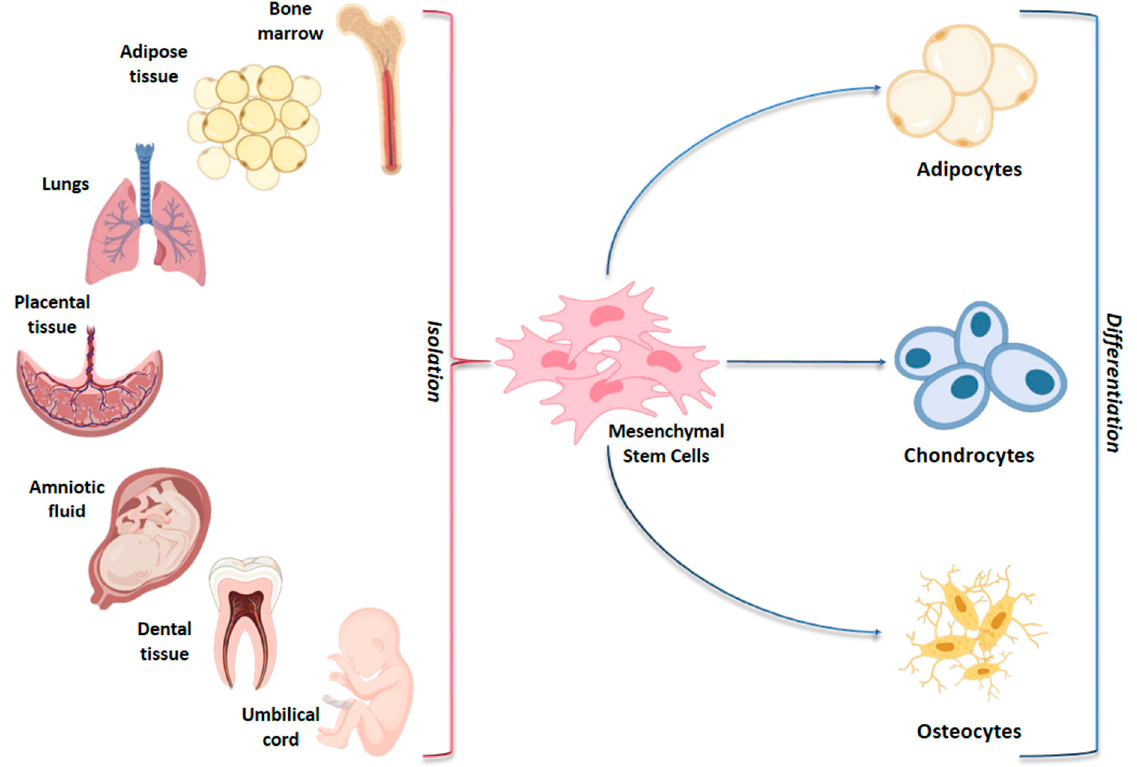
Figure 1. Schematic representation of adult and fetal/neonatal tissue sources of mesenchymal stem cells (MSCs) and their potential of differentiation in various cell lines. MSCs can be isolated from several tissue sources in the body and they may differentiate into adipocytes, chondrocytes and osteocytes.